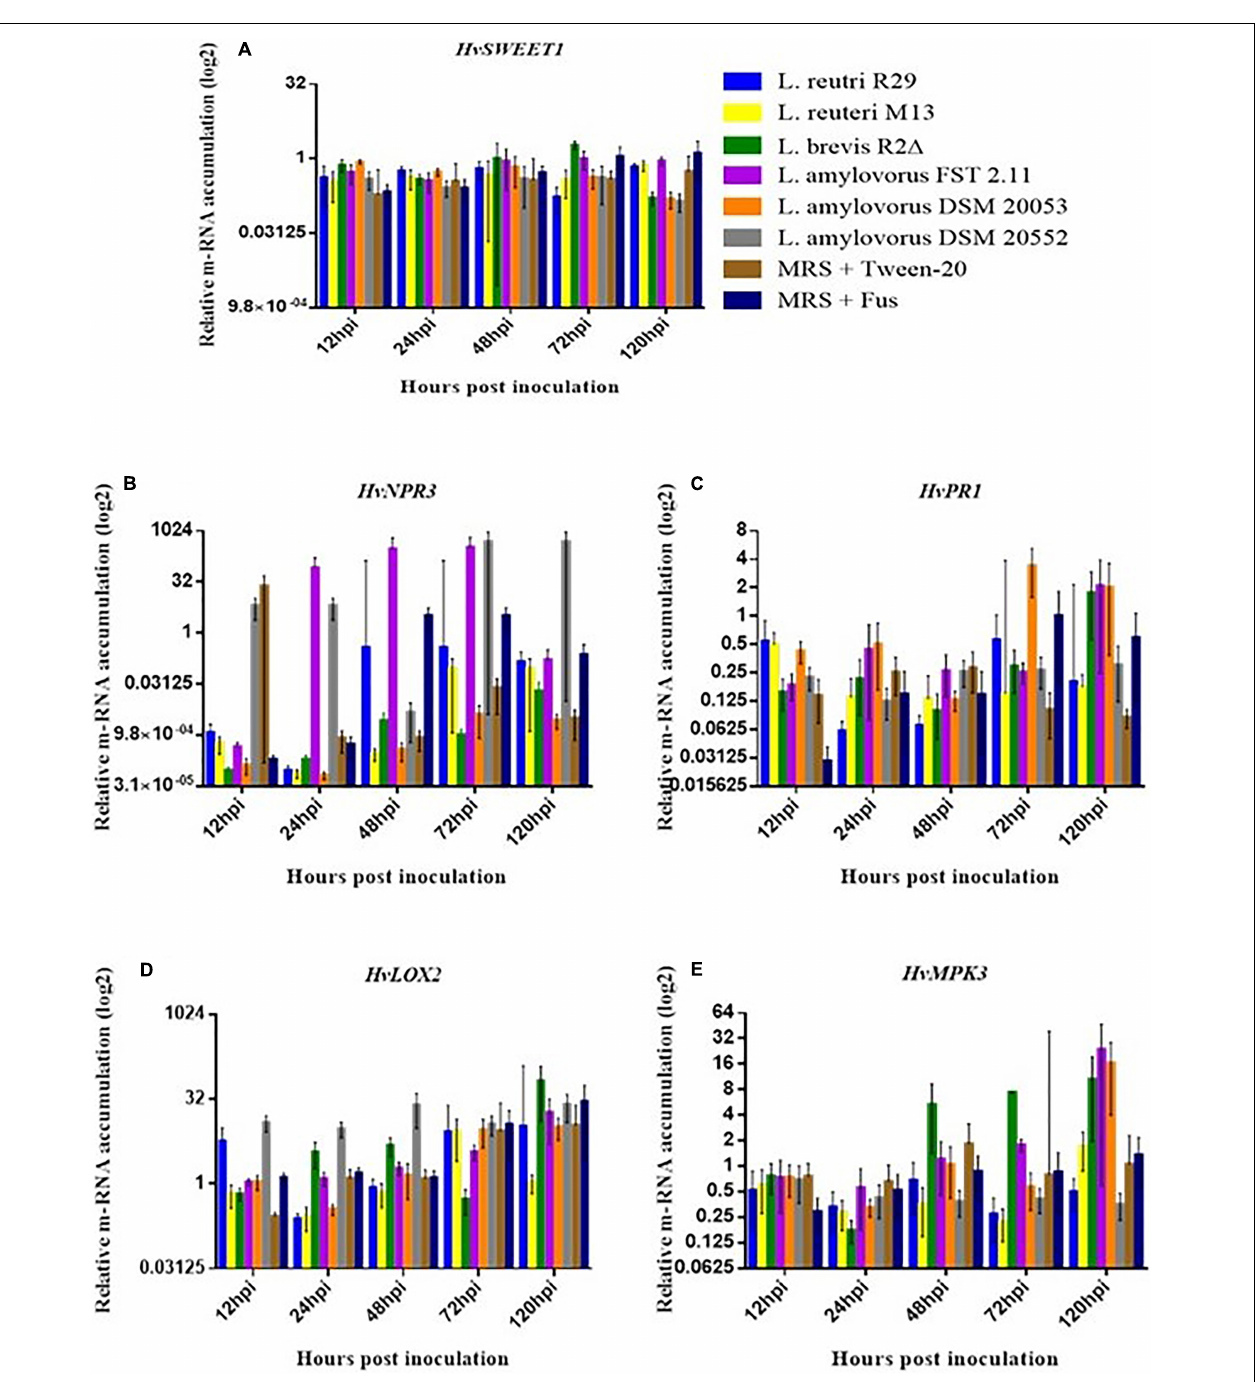
FIGURE 5 | Relative gene expression level in barley head tissue harvested at 12, 24, 48, 72, and 120 hpi of fungal inoculation. (A) HvSEEWT1, (B) HvNPR3, (C) HvPR1, (D) HvLOX2 and (E) HvMPK3 . Error bars indicate ± SEM ( n = 8). Asterisks show significant differences between expression levels (* P , 0.05).